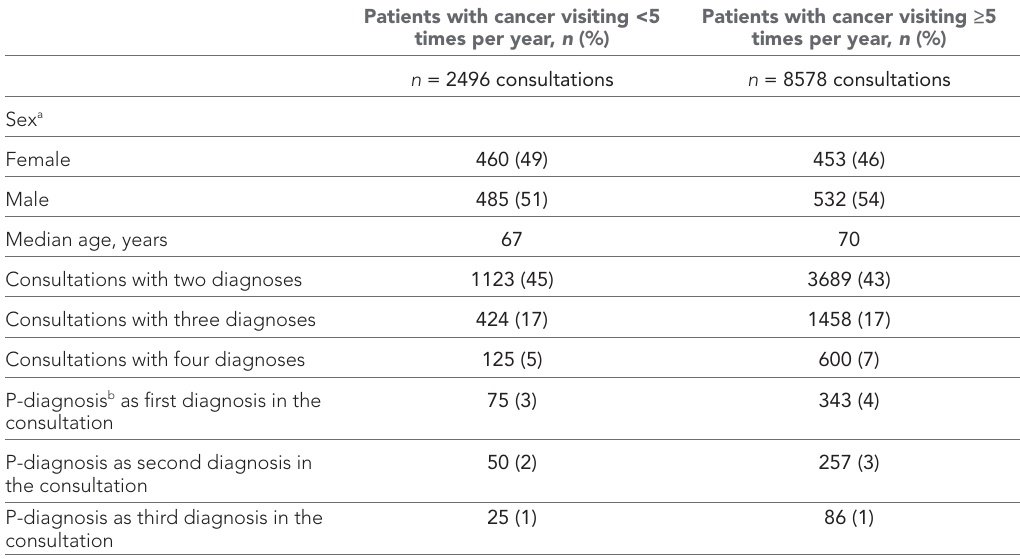
Table 2 Characteristics of patients with cancer by frequency of visits to the GP in a 1-year study (consultations n = 11 074, patients with cancer n = 1932, GPs n = 91) Patients with cancer visiting <5 Patients with cancer visiting ≥5 times per year, n (%) times per year, n